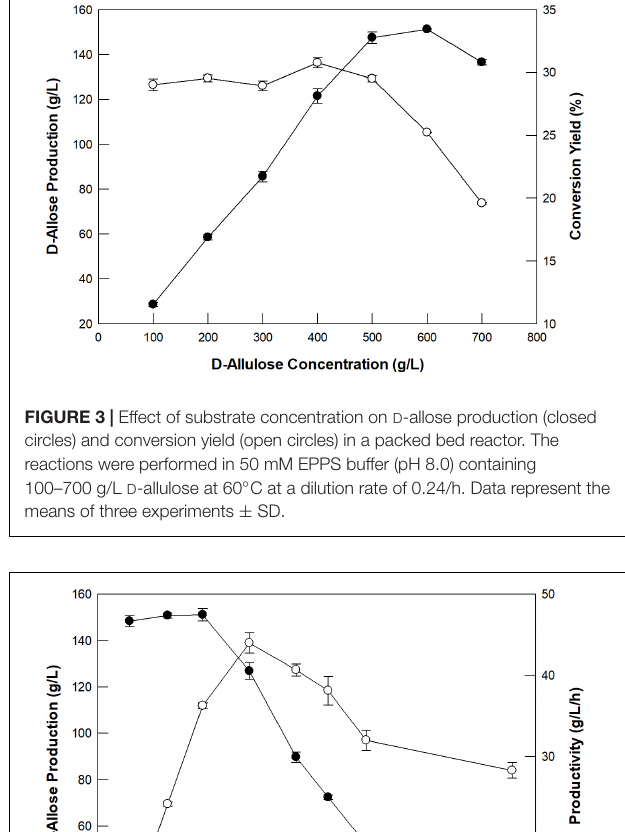
D -glucose-6-phosphate isomerase from P. furiosus (Yoon et al.,